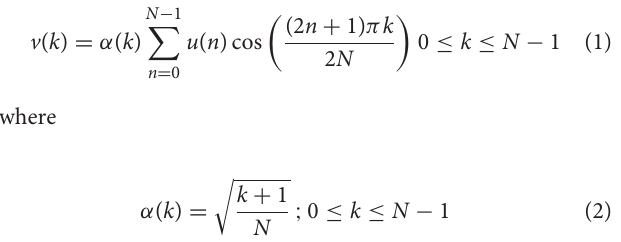
types of neurons with the pool of extracted spikes. With a visual judgment, variability of spike waveforms of different types of neurons is